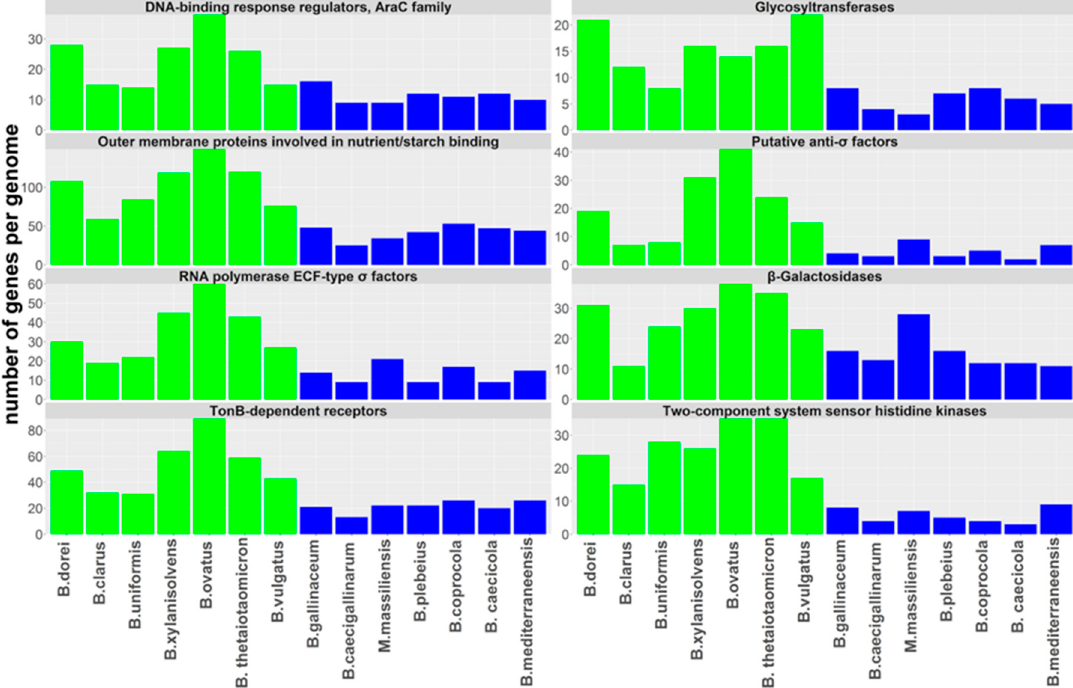
Figure 4. Number of genes belonging to specific gene families in human- and chicken-adapted Bacteroides species. Eight gene families exhibited a significantly higher number of genes in the genomes of human-adapted Bacteroides isolates compared to those from chickens (Mann–Whitney test, p < 0.05). Human-adapted Bacteroides species (green columns) harbored significantly more genes coding for proteins sensing extracellular conditions and polysaccharide binding and transport than chicken-adapted Bacteroides species (blue columns). See Table S4 for the list of genes belonging to all gene families in human- and chicken-adapted Bacteroides species.